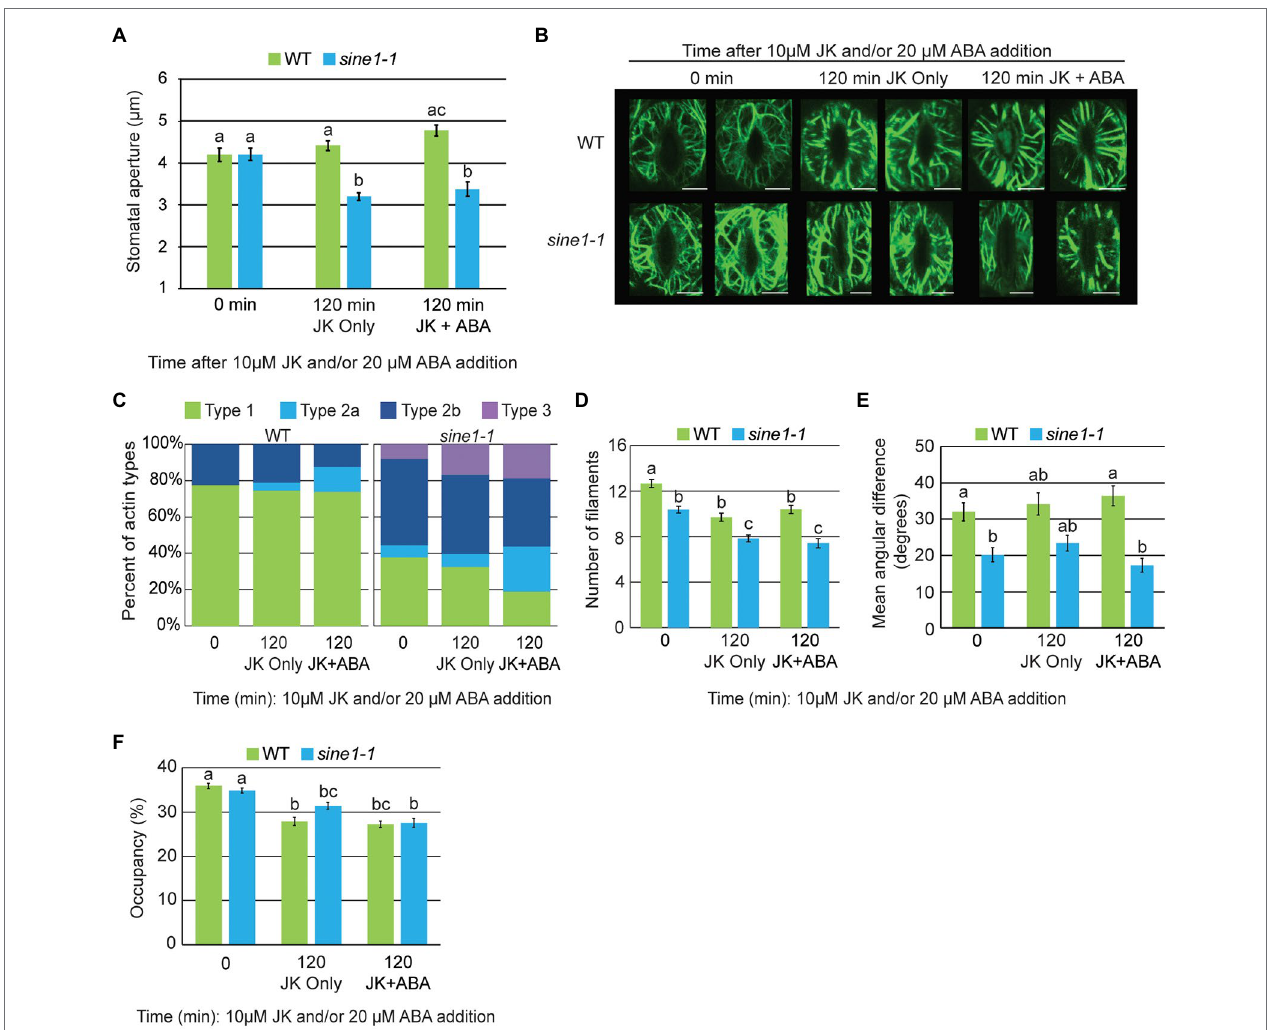
FIGURE 2 | F-actin stabilization results in abnormal actin patterning in sine1-1 during stomatal closure. (A) Stomatal aperture measurements for WT and sine1-1 GFP-LIFEACT lines at 0 and 120 min after addition of 10 μ M JK or 10 μ M JK + 20 μ M ABA. Data are mean values ± SE from three independent experiments ( N ≥ 24 stomata). Statistical significance was calculated using Student’s t -test, and lowercase letters denote groups that are statistically different ( p < 0.01). (B) Representative maximal intensity projections of actin organization at 0 and 120 min after addition of 10 μ M JK or 10 μ M JK + 20 μ M ABA. Scale bars = 5 μ